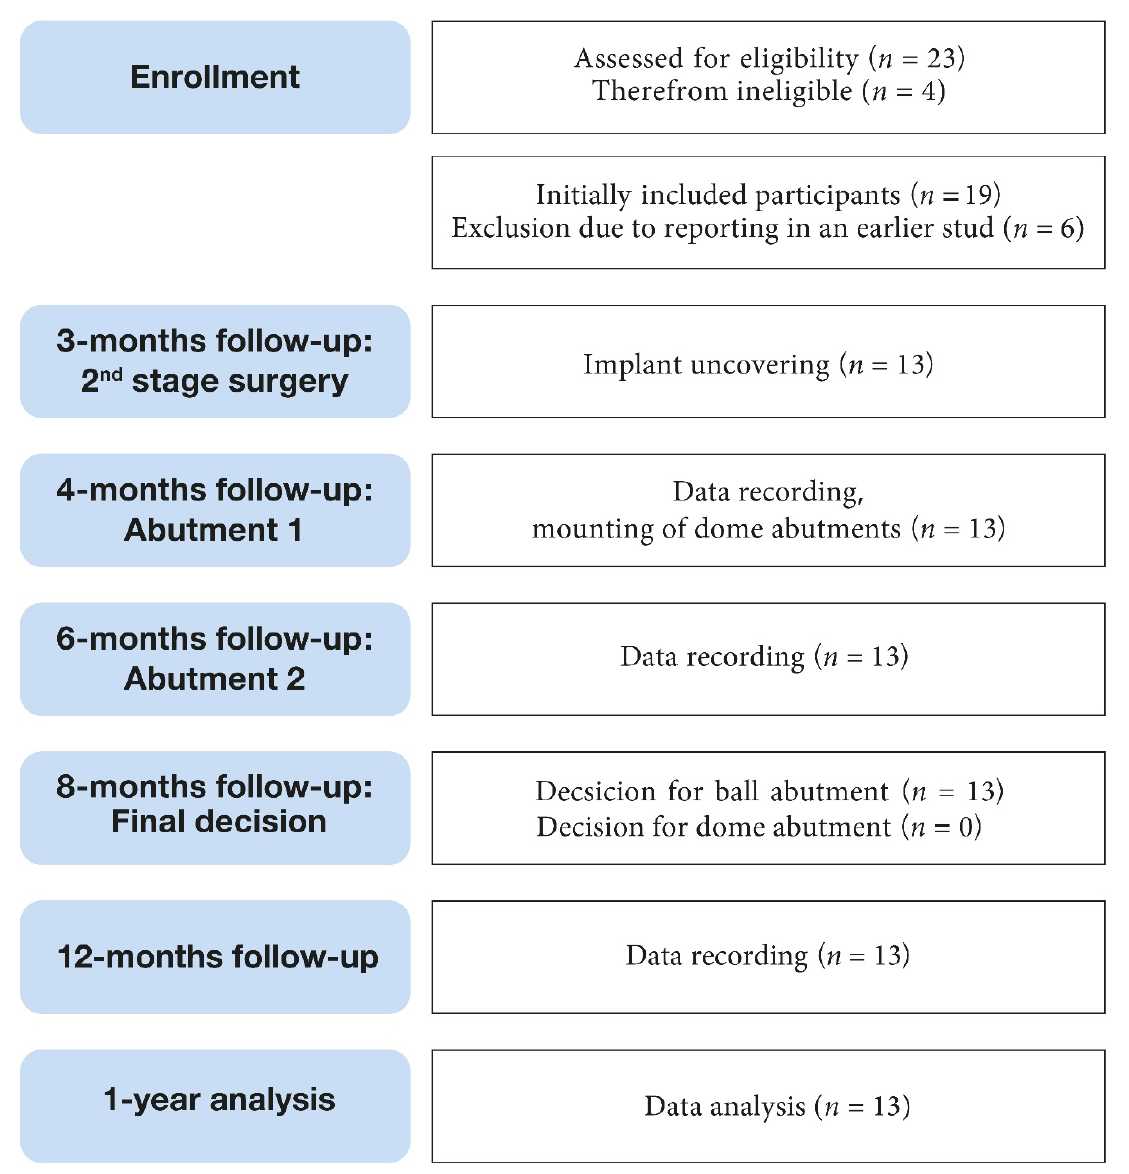
Figure 4. Flow-chart summarizing the study